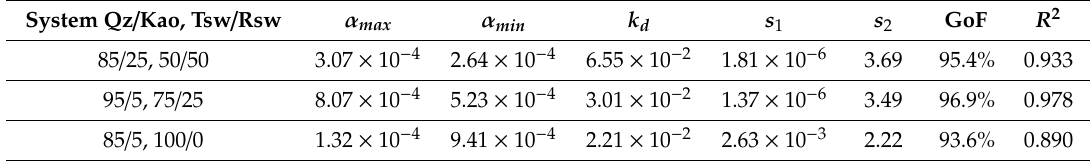
Figure 9. Experimental (symbol) vs. calculated (lines) flocculation kinetic. Solid concentration 13 wt%, flocculant dose 15 g/t, mixing intensity 188 s − 1 . Three conditions are evaluated according Table 4. Table 4. Parameters used to the model description, GoF, and R 2